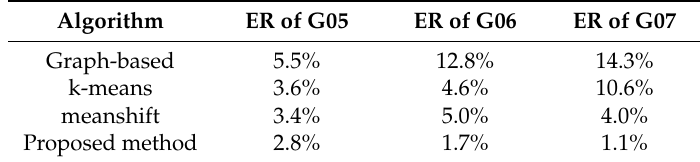
Table 5. Error ratio (ER) comparison with automatic image segmentation algorithms.